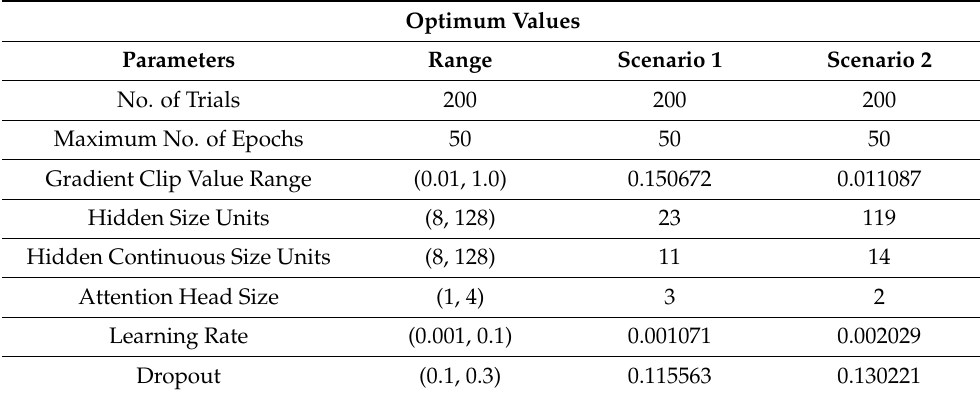
Table 2. Parameters for the optimal